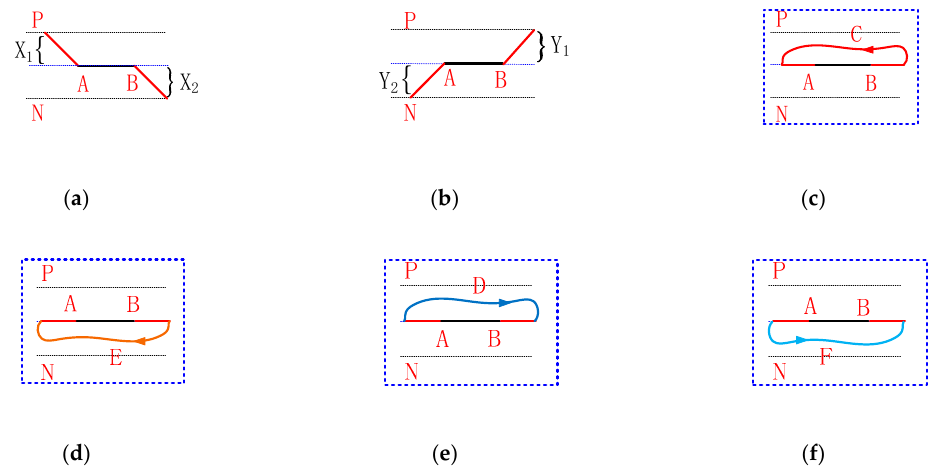
Figure 21. Six modes based on unified topology under DFUSPWM. ( a ) PC mode; ( b ) NC mode; ( c ) PFT mode; ( d ) PFB mode; ( e ) NFT mode; ( f ) NFB mode.